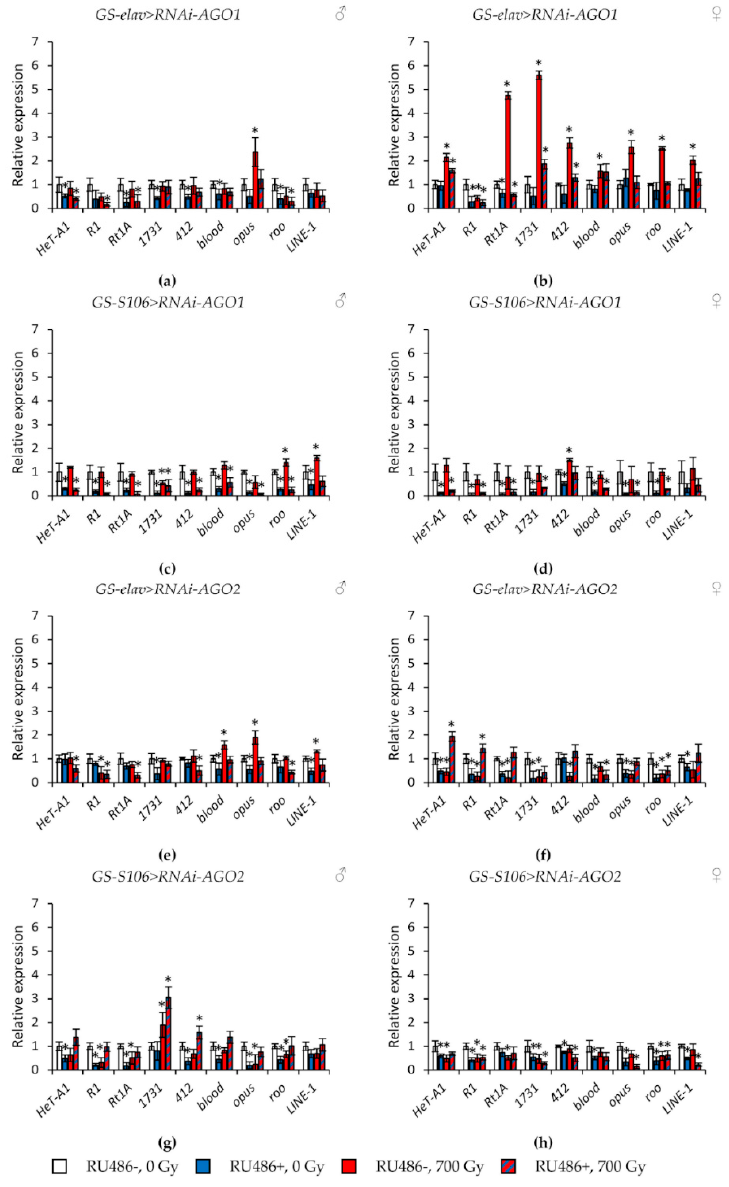
Figure 5. Changes in the expression of retrotransposons in irradiated and unirradiated males ( a , c , e , g ) and females ( b , d , f , h ) with AGO1 ( a – d ) and AGO2 ( e – h ) knockdown. Differences between relative expression levels of retrotransposons of unirradiated flies without Argonaute genes’ knockdown (RU486-, 0Gy) and each of other experimental variants are statistically significant with * p < 0.05 (Mann-Whitney